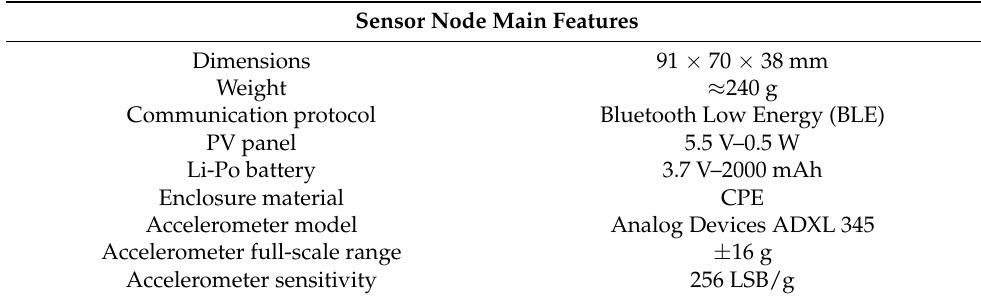
Table 1. Main features of the WindNode